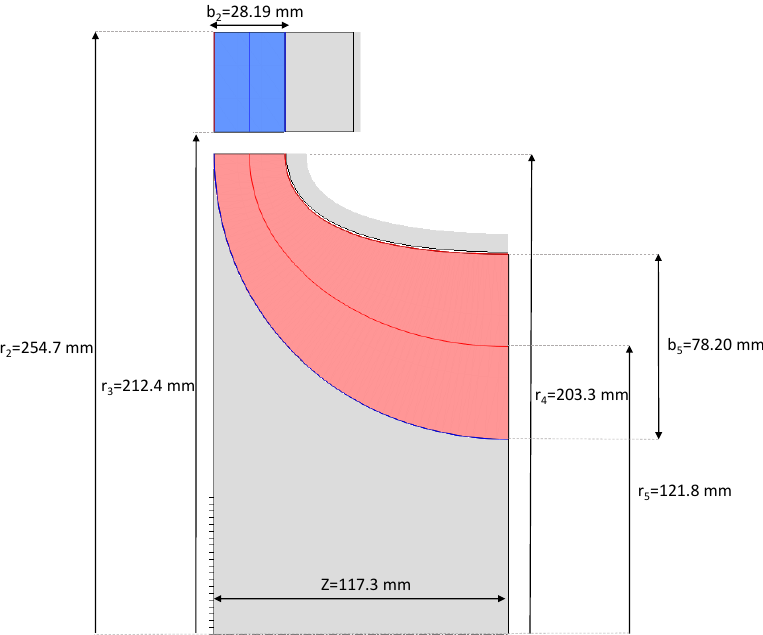
Figure 4. Meridional dimensions of selected